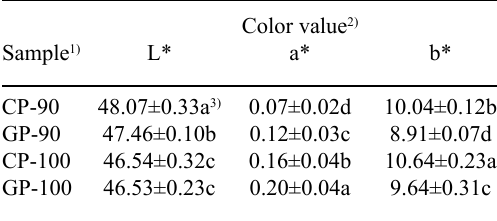
table 2. Hunter’s color values of cultivated Pu-erh (CP) and Gushu Pu-erh (GP) tea extracts